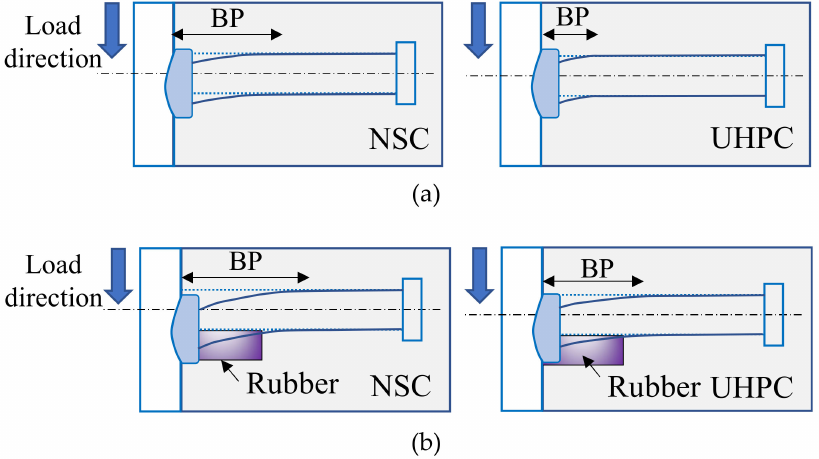
Figure 13. Deformation of shear connectors in NSC and UHPC: ( a ) ordinary stud shear connectors; ( b ) rubber-sleeved stud shear